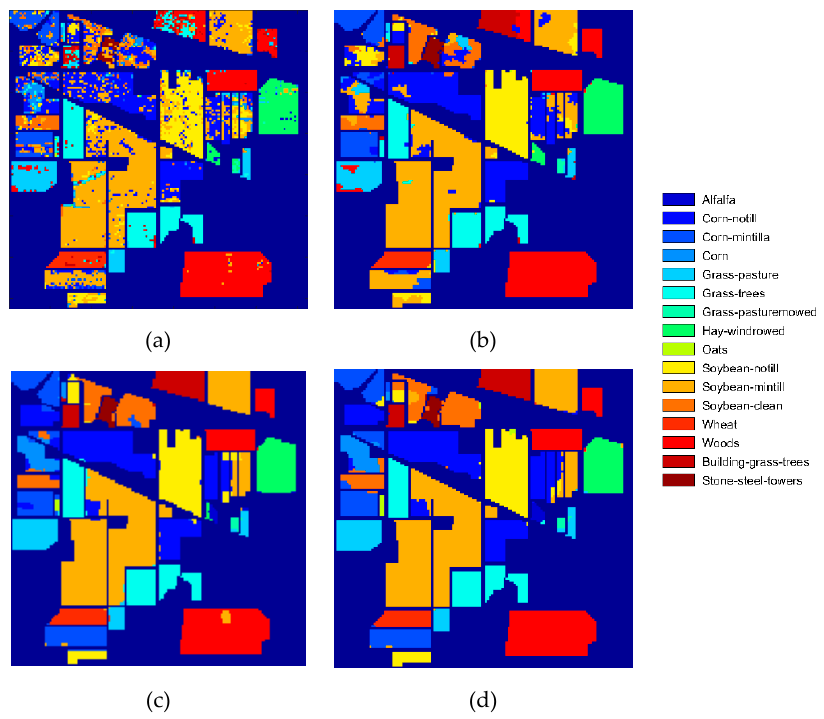
Figure 6. The classification results of Indian Pines dataset. ( a ) SVM. ( b ) SVM-SP ( s = 5). ( c ) DPR-SVM-POS (m = 15, s = 5 and β = 0.9). ( d ) DPR-SVM-SP ( s = 5 and β = 0.9).